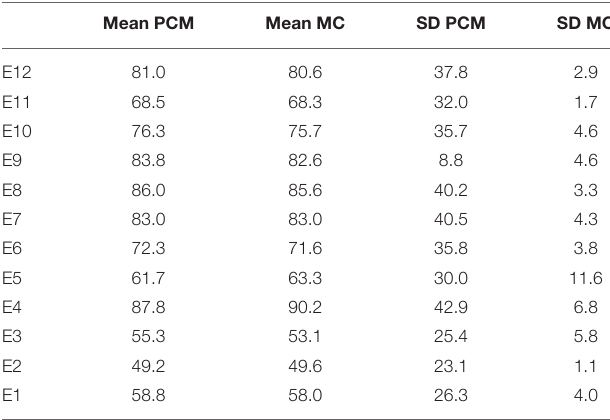
TABLE 1 | Local performance score.